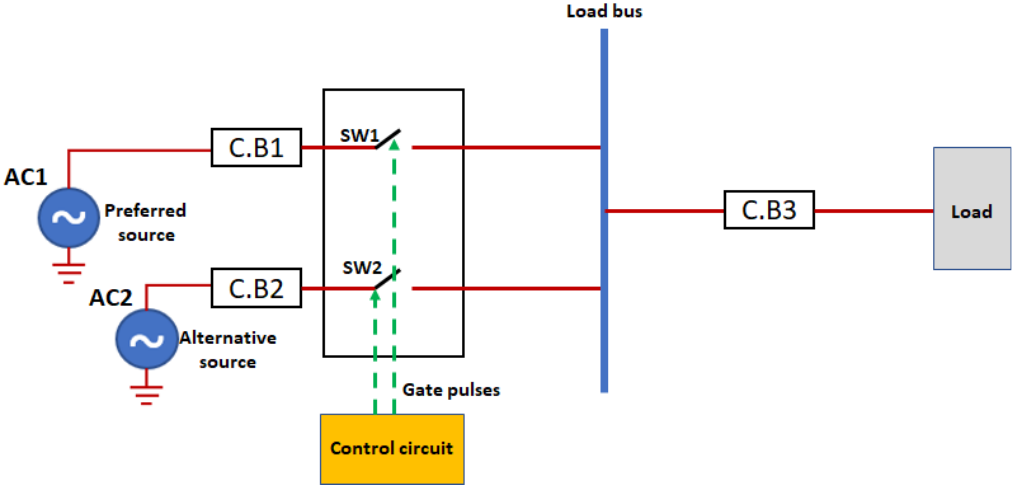
Figure 1. Basic configuration of the AC source switching-based static transfer switch. Table 1. Comparison of the different semiconductor devices’ performance s.